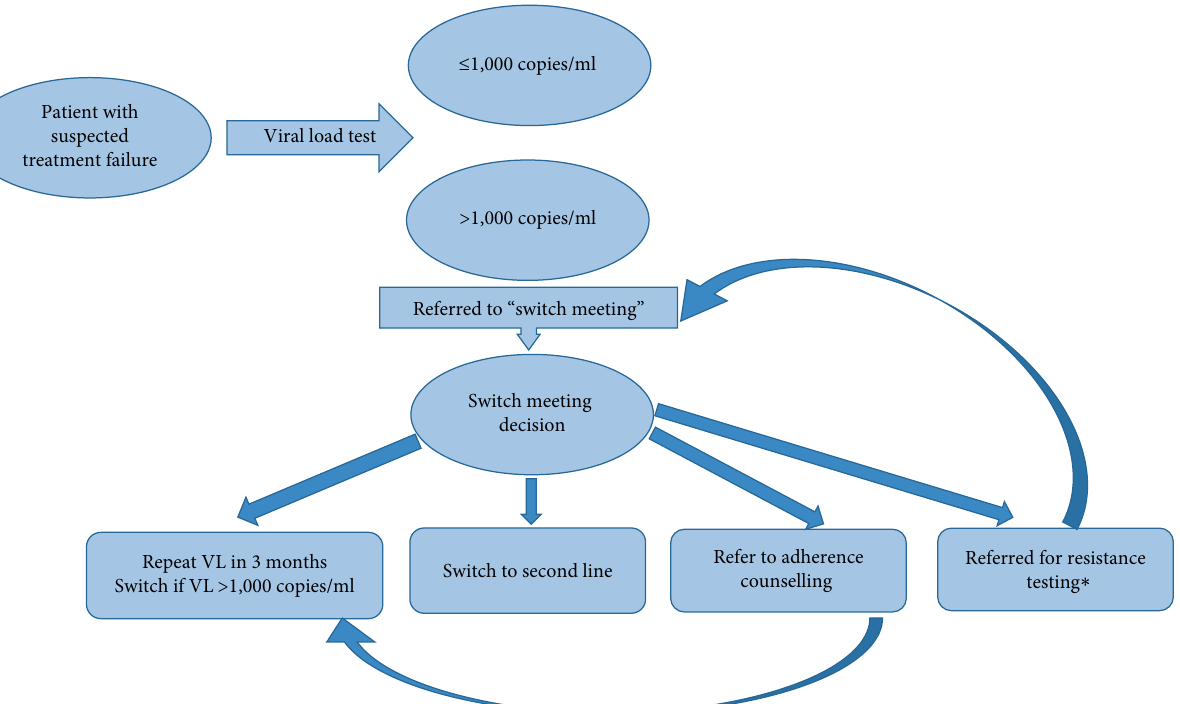
Figure 1: The figure demonstrates all the steps the patients with detectable viral load underwent, Via switch-meeting-including ref-feral for adherence counselling, repeat VL after 3 months of IAC, switching to 2nd line treatment and referral for resistance